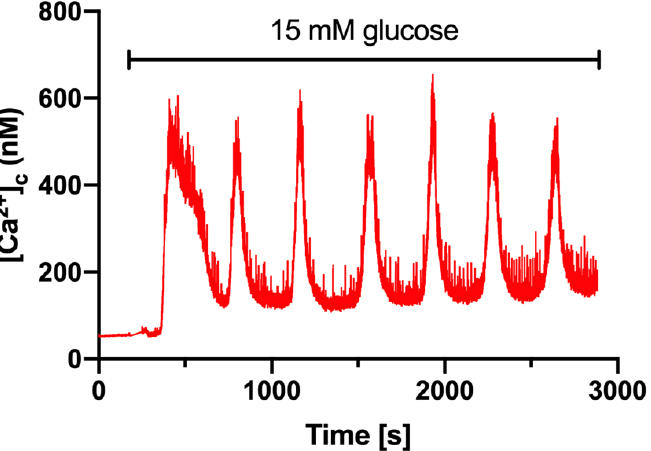
Figure 10. Primary mouse β -cells display the archetypal glucose-induced oscillatory calcium phe- notype when cultured on laminin. Exemplar trace demonstrates robust cytosolic calcium oscilla- tions in primary mouse β -cells in response to 15 mM glucose stimulation.